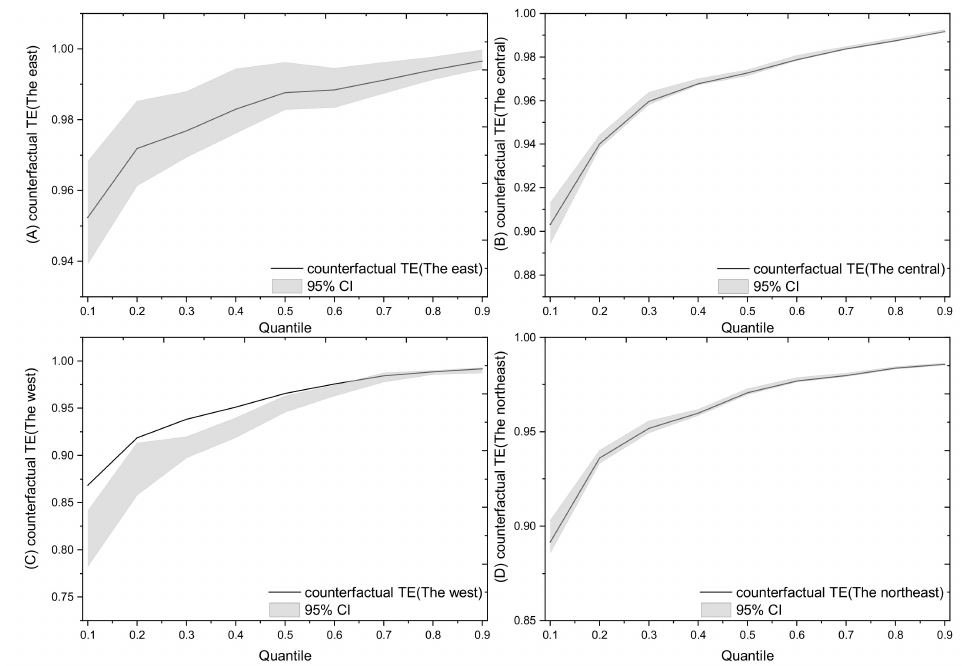
Figure 4. Counterfactual estimated TE changes in the east, the central, the west and the northeast with 95% confidence intervals.